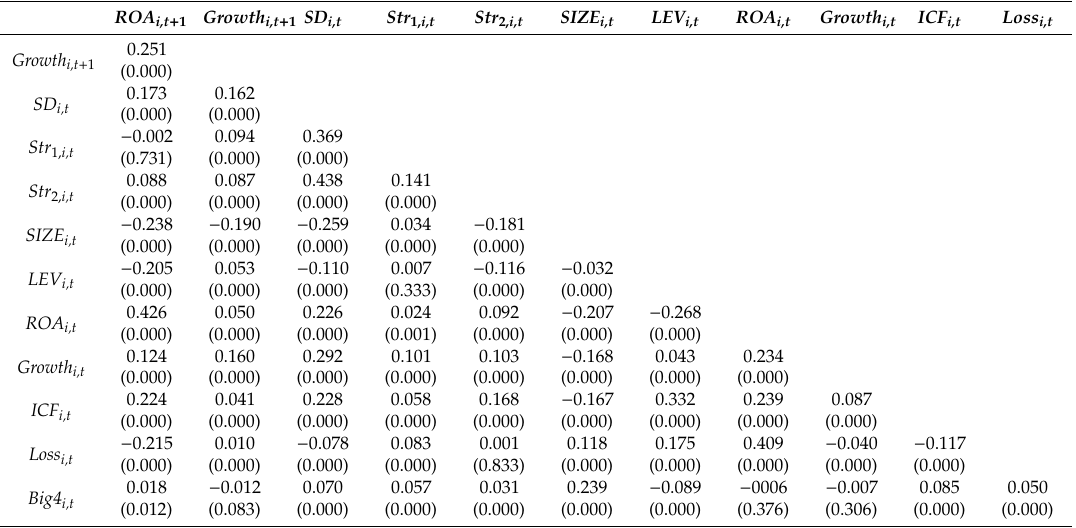
Table 4. Pearson’s correlation among variables (n = 20,216) a